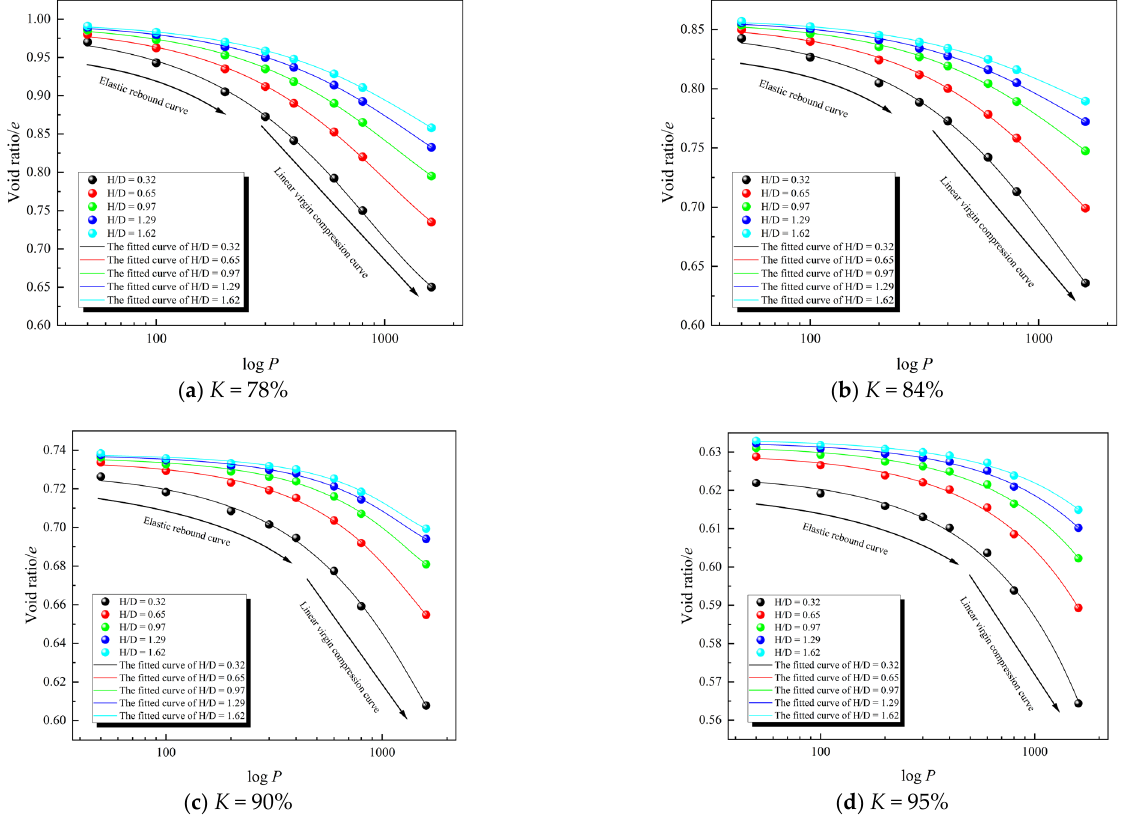
Figure 6. The compression curves of different H/D ratios under various compaction degrees.